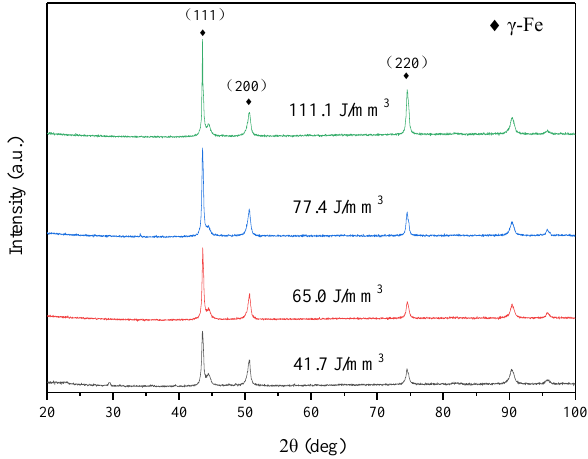
Figure 4. XRD pattern of the stainless steel parts processed by SLM under different ω. Table 3. XRD data showing the 2 θ values, intensity, and peak FWHM of the main peaks.